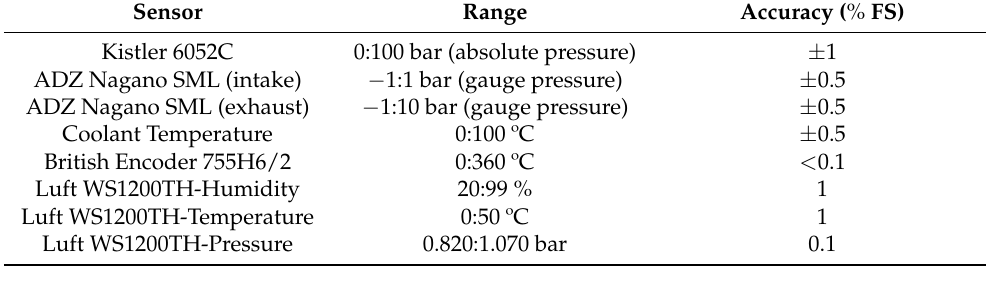
Table 2. Sensor Specifications. Accuracy is given as a percentage of each sensor full scale (% FS).